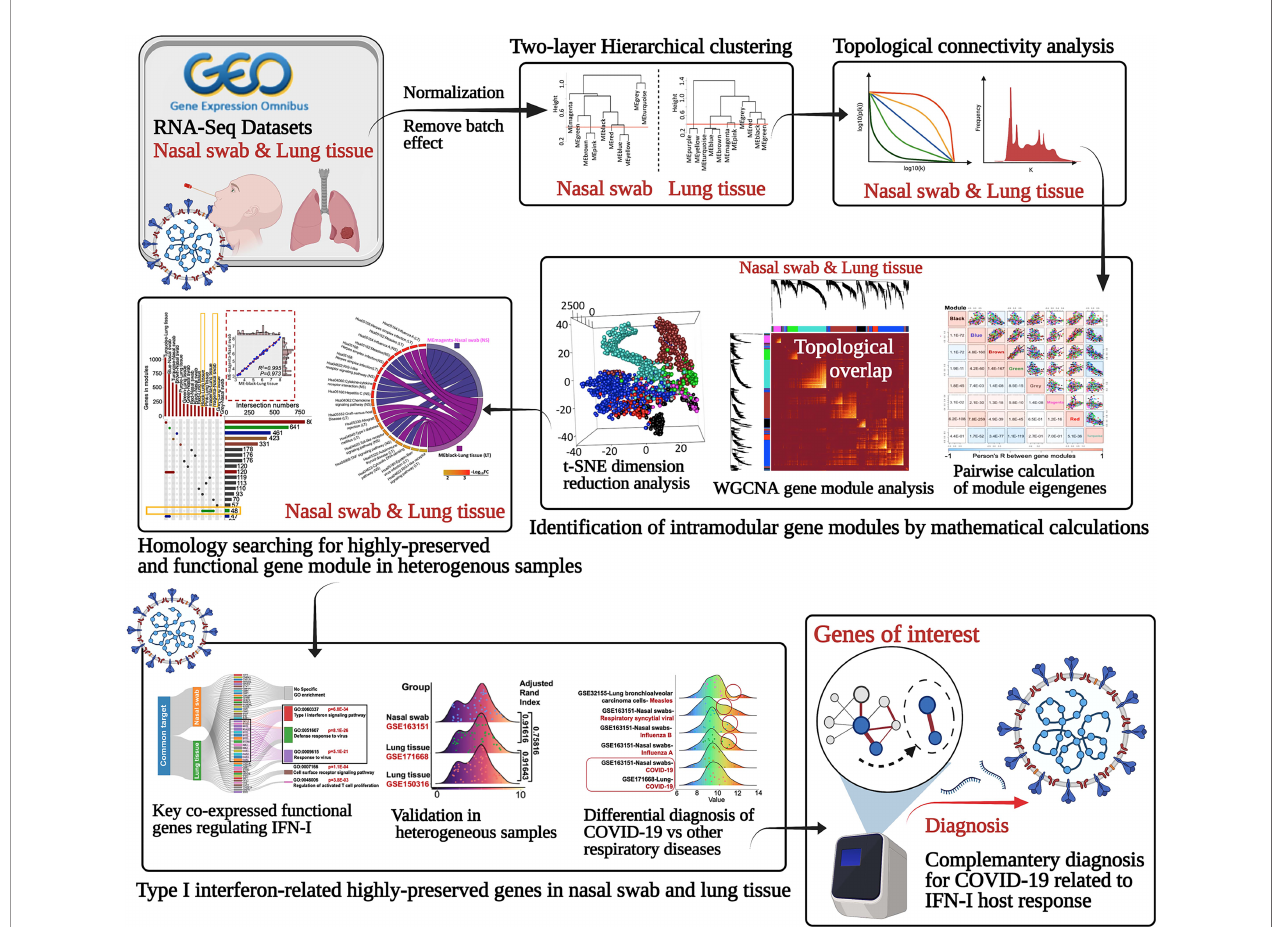
FIGURE 1 | Schematic of identifying the underlying the highly-preserved genes from heterogeneous samples for COVID-19